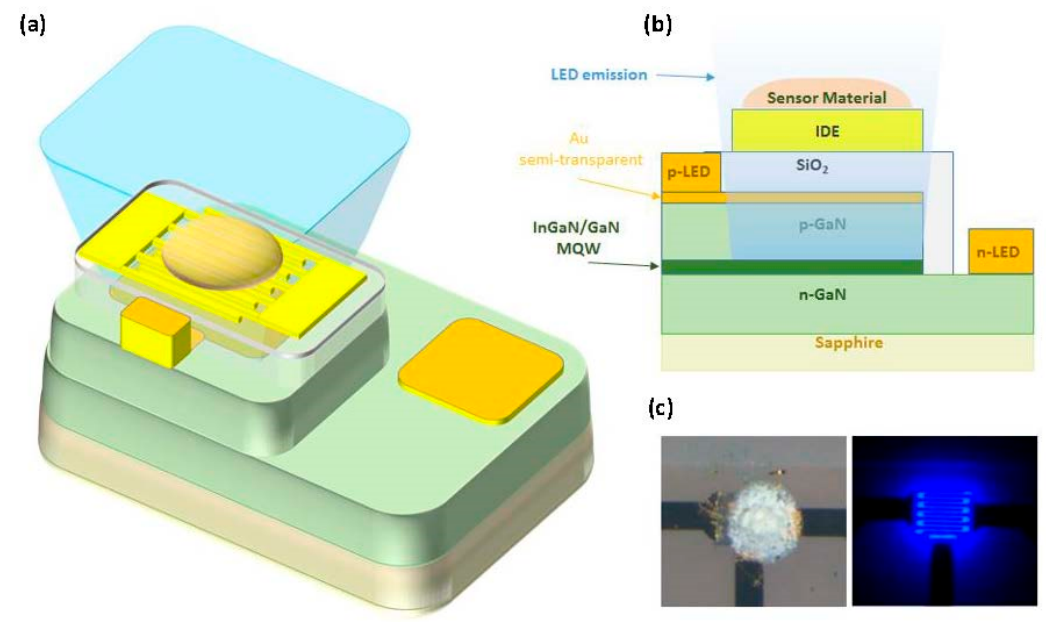
Figure 1. LED platform. ( a , b ) 3D view and cross-section of the design, including the substrate, the LED structure and its contacts and insulation layers, topped with the IDE electrodes and the sensor material. Light is emitted directly beaming the IDE region. ( c ) Microscope images of (left) the finished device with the ZnO nanowires deposited on top and (right) the LED lit on and emitting only under the IDE (before depositing the